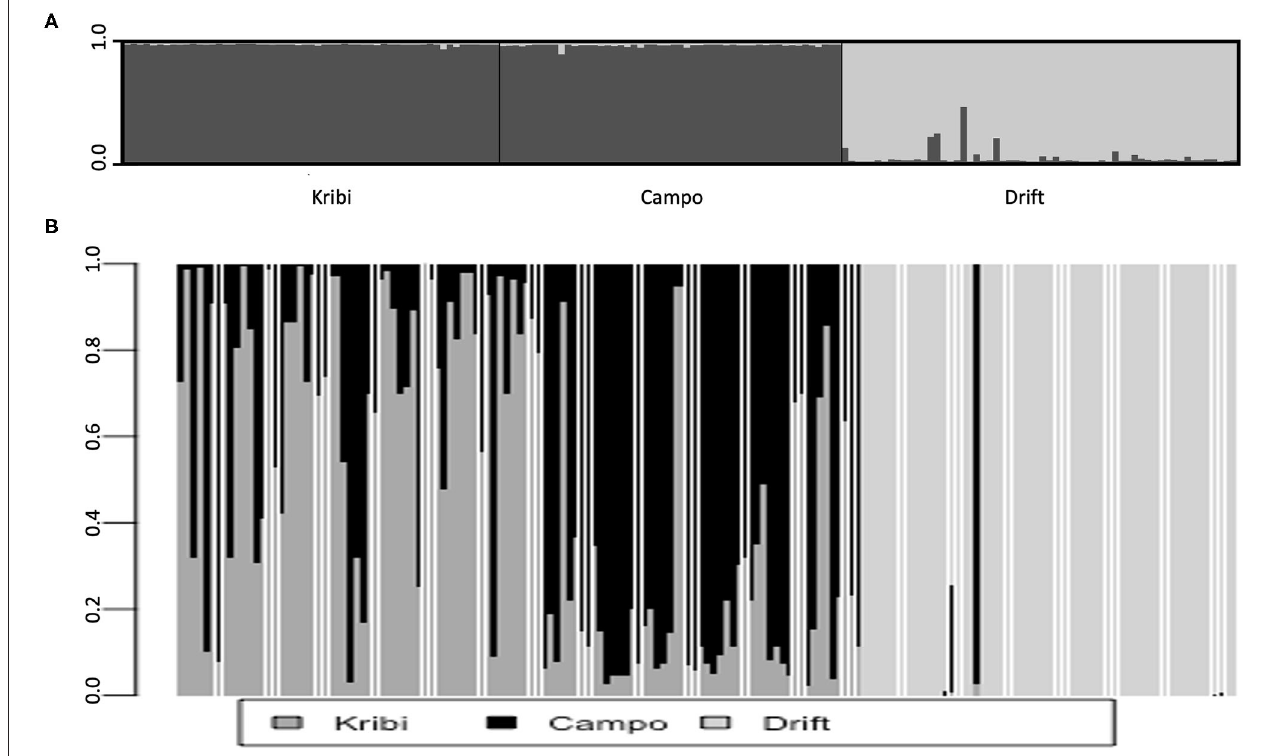
FIGURE 4 | Bayesian clustering analyses (A) and Compoplot of all samples assignment based on DAPC (B) both show the Drift propagules form a single cluster which is isolated from Kribi and campo cluster. Compolot show more admixture in individuals from the Kribi and Campo but not the drift propagules.